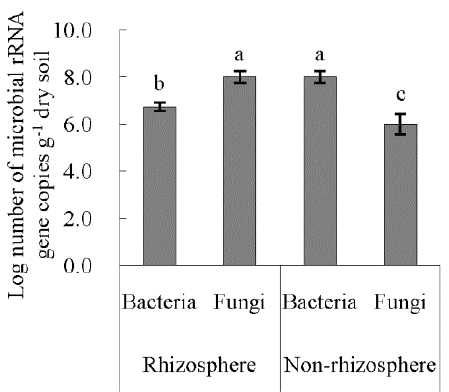
Figure 6. Abundance of rhizosphere and non-rhizophere soil bacteria and fungi rRNA genes in copper tailings dam. The different case letters indicate that the means are significantly different among reclaimed scenario ( P < 0.05) with Duncan test (a > b > c).